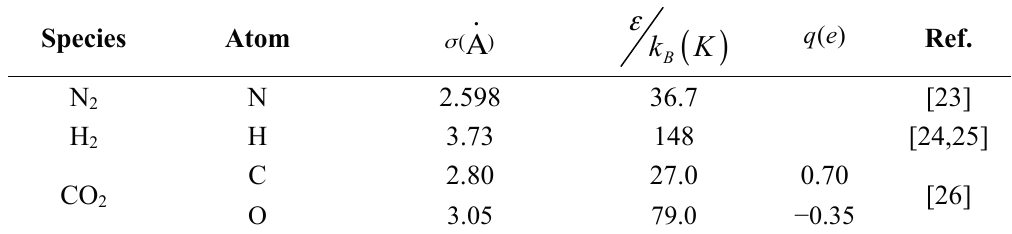
Table 3. LJ parameters and partial atomic charges for N 2 , H 2, and CO 2 atoms.